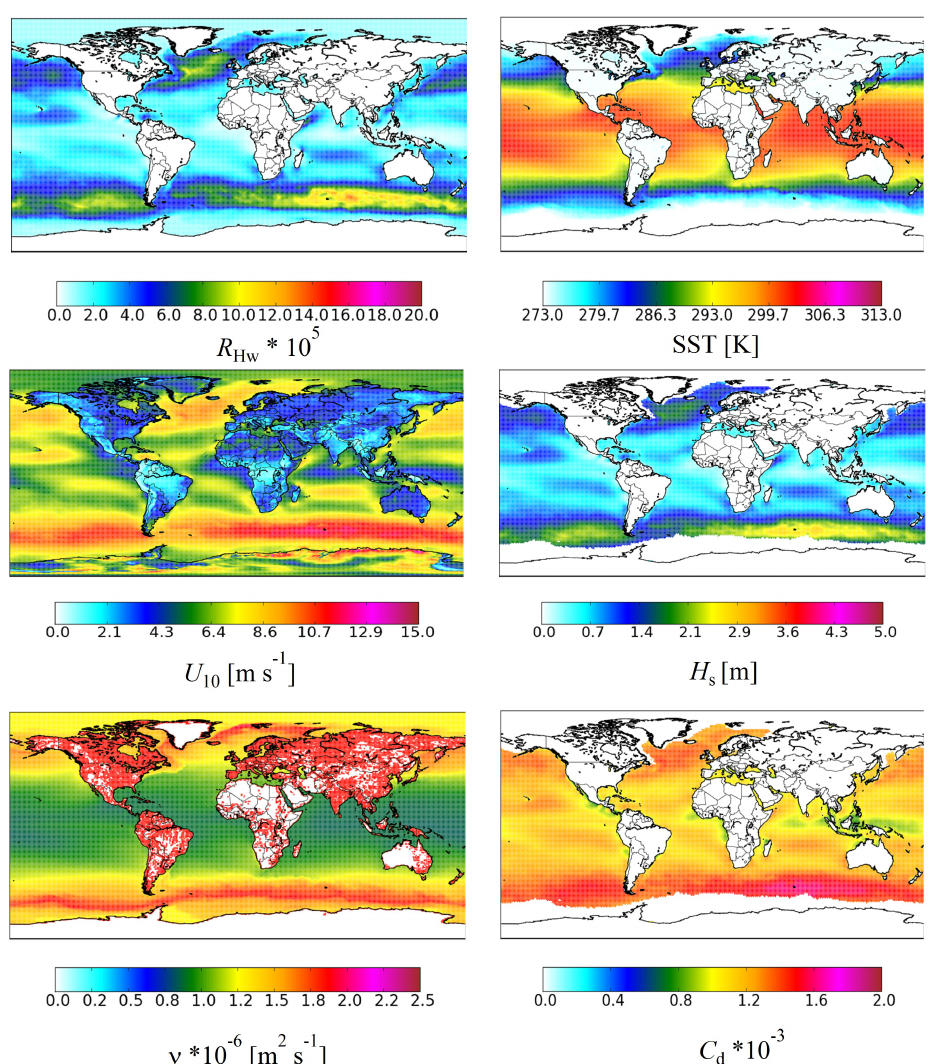
Fig. 8. Annual mean values of meteorological/oceanographic fields (ECMWF) that were used for the calculation of the sea spray aerosol fluxes for